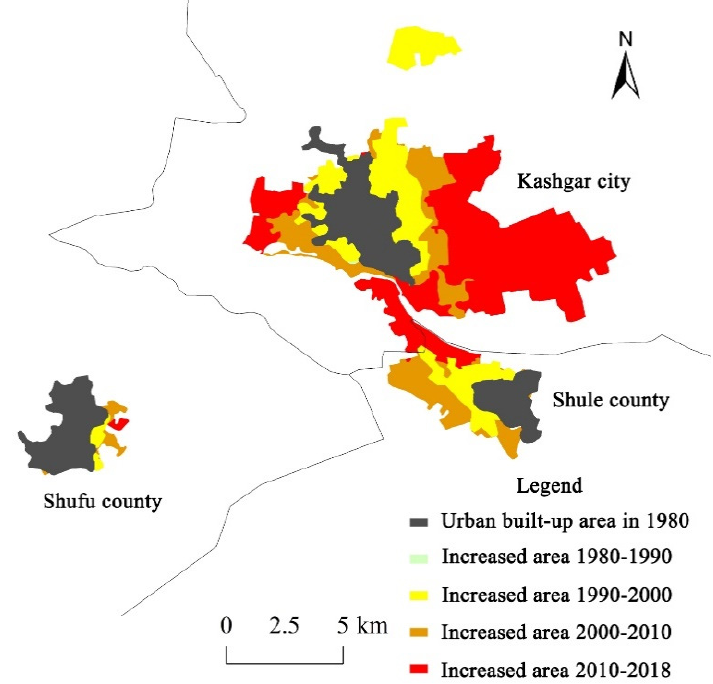
Figure 8. A schematic diagram of the spatial expansion of the urban built–up area. We used Equations (2) and (3) to obtain the economic distance and gravity from each city to Kashgar, the central city (Table 5). Table 5 shows that Shule County, Artux City, Shufu County, and Akto County have economic distances of less than 20 km. The gravity between these cities and Kashgar City is also greater than 1 million, indicating that these cities are the most closely related to the economy of the core cities. The economic distance of Akqi County is more than 1000 km, indicating that it has the weakest link to the core